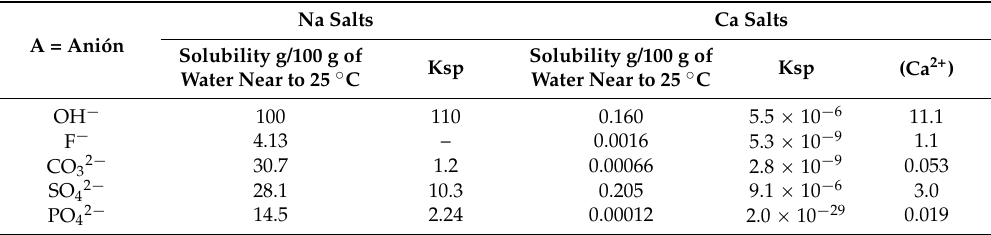
Table 1. Solubility (g of solute/100 g of water) and the Solubility Product Constants, K sp of sodium and respective calcium salts and equilibrium calcium concentration (Equation